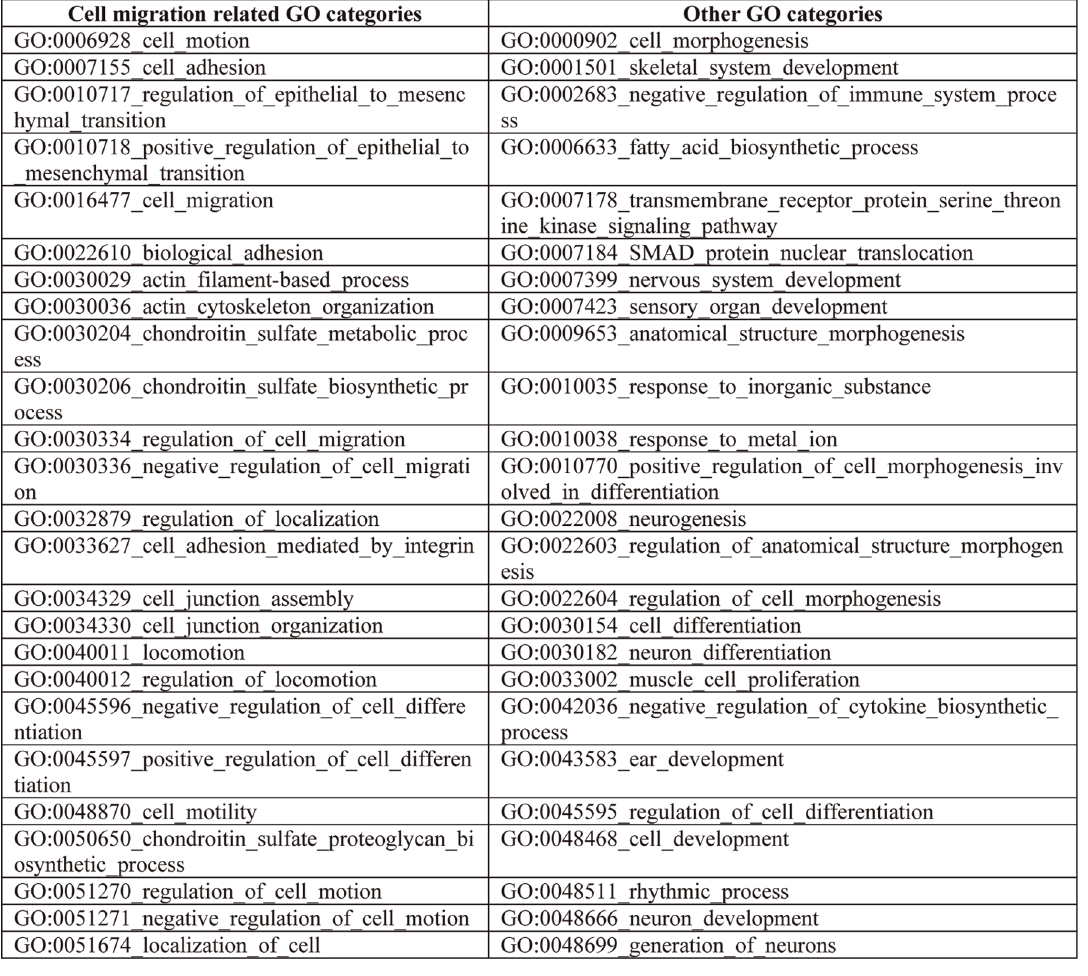
Figure 1. Gene Ontology (GO) categories associated with the 83 genes in cluster 52/160 (see Methods ).